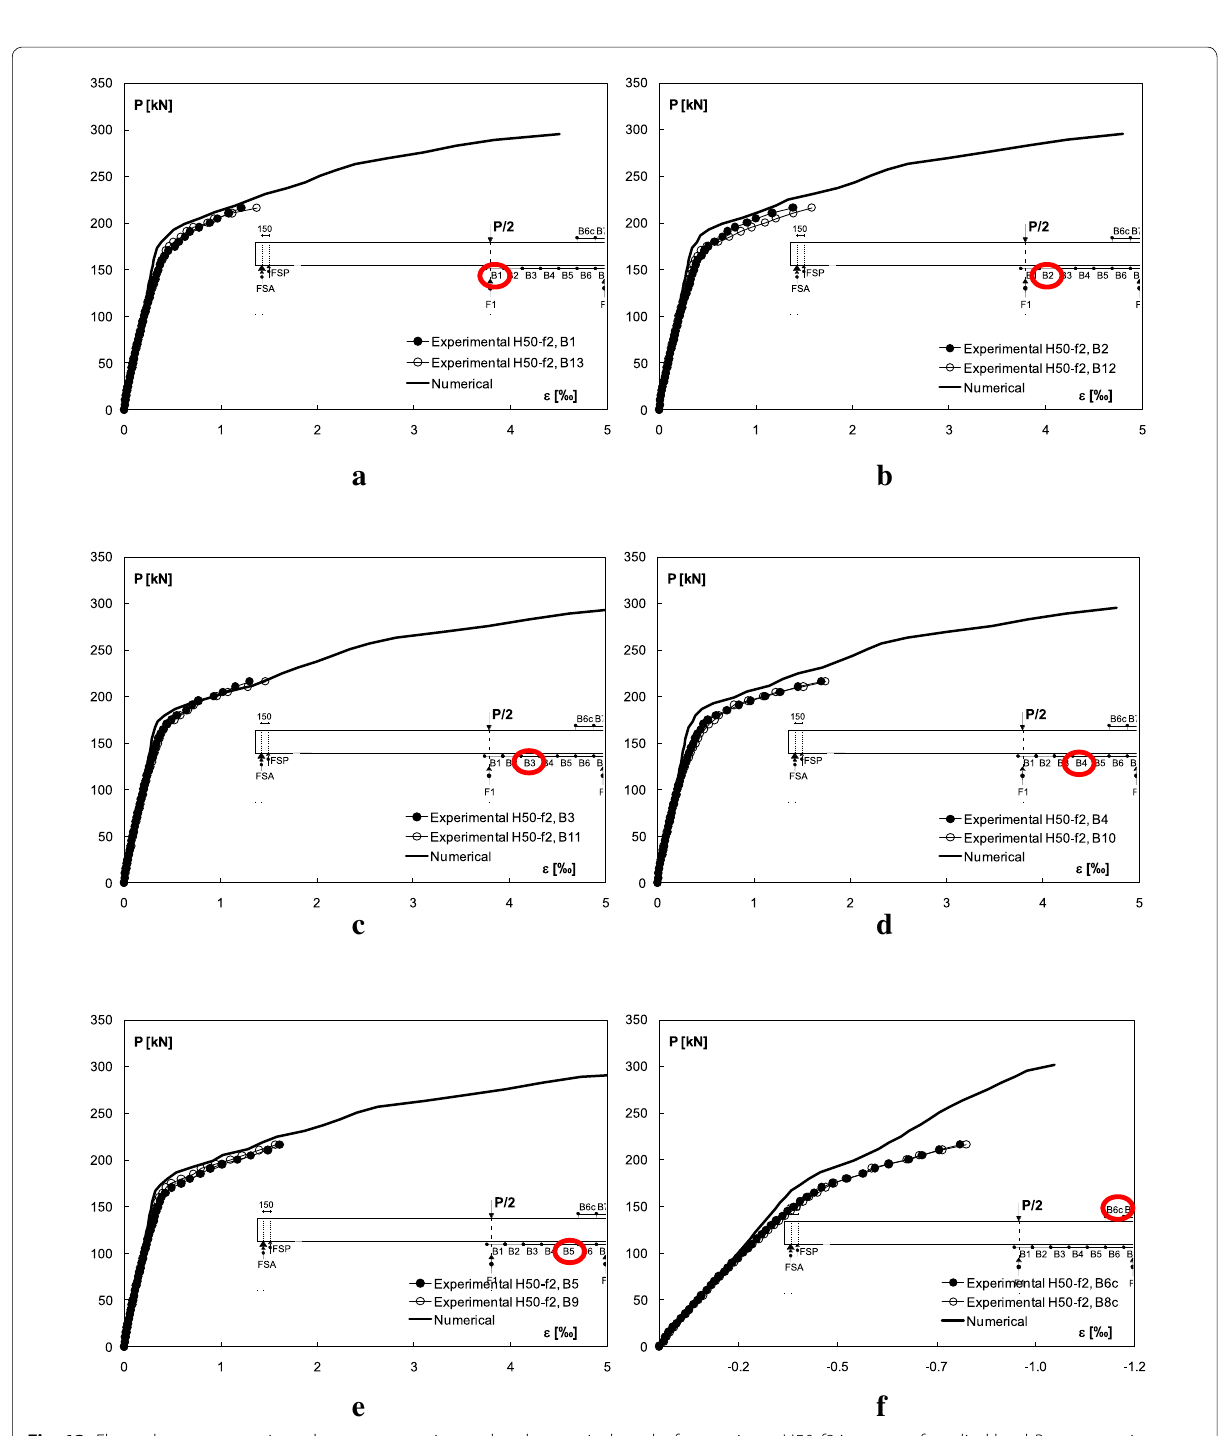
Fig. 13 Flexural tests: comparisons between experimental and numerical results for specimen H50-f2 in terms of applied load P versus strain ε obtained from devices a B1-B13, b B2-B12, c B3-B11, d B4-B10, e B5-B9, f